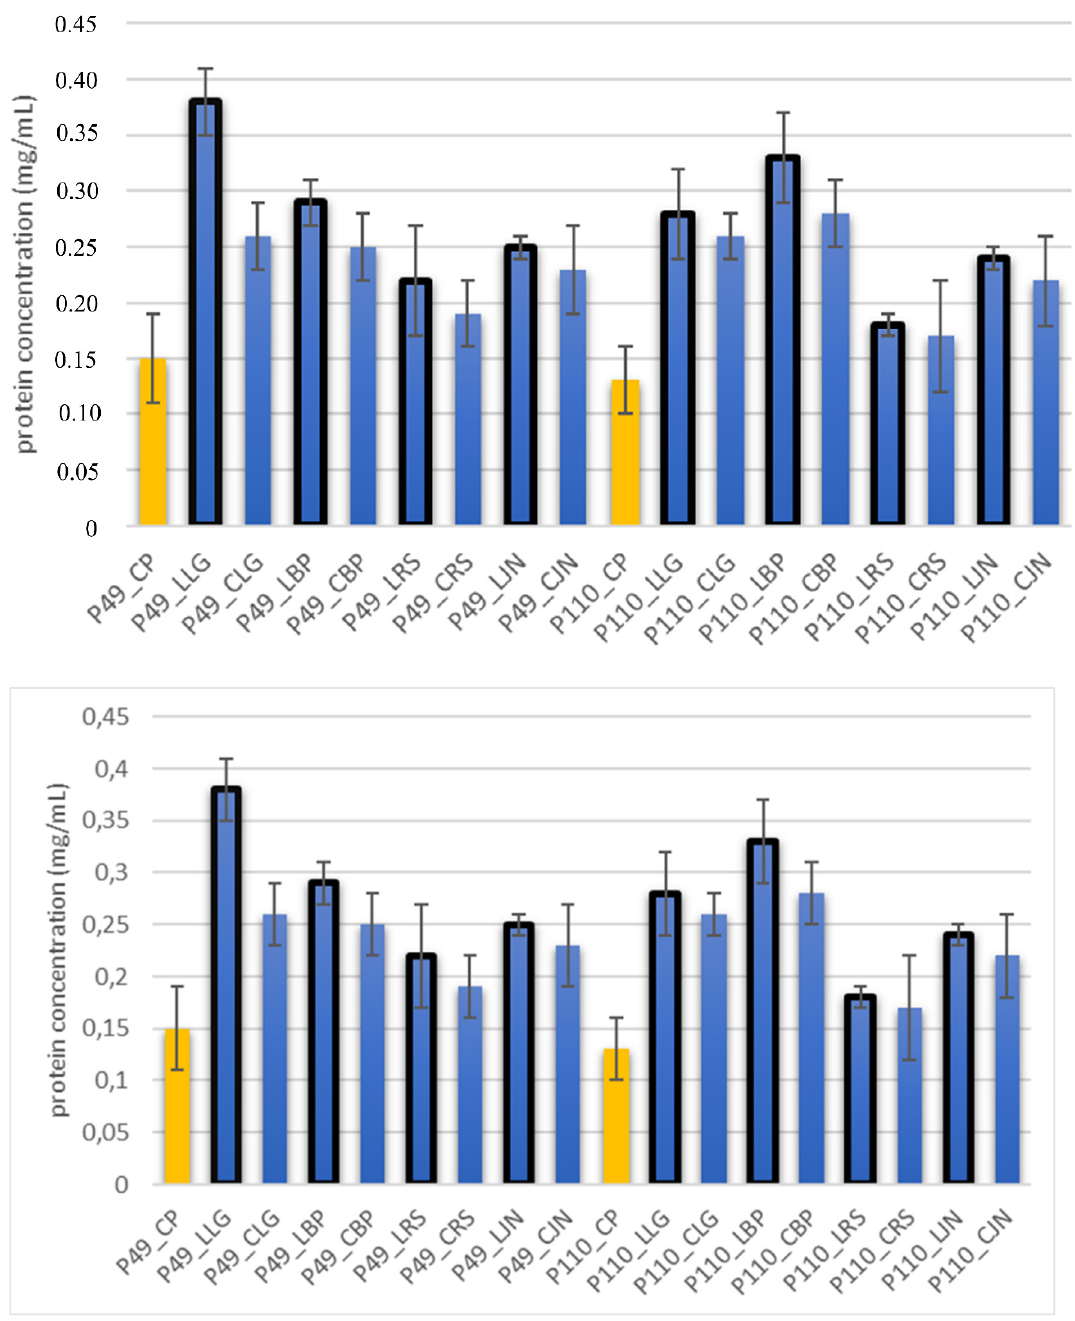
Figure 3. The level of proteins released in bacteria cultivation supplemented with essential oils in MIC levels, control probes are shown as orange columns, columns of laboratory oils have a black frame.